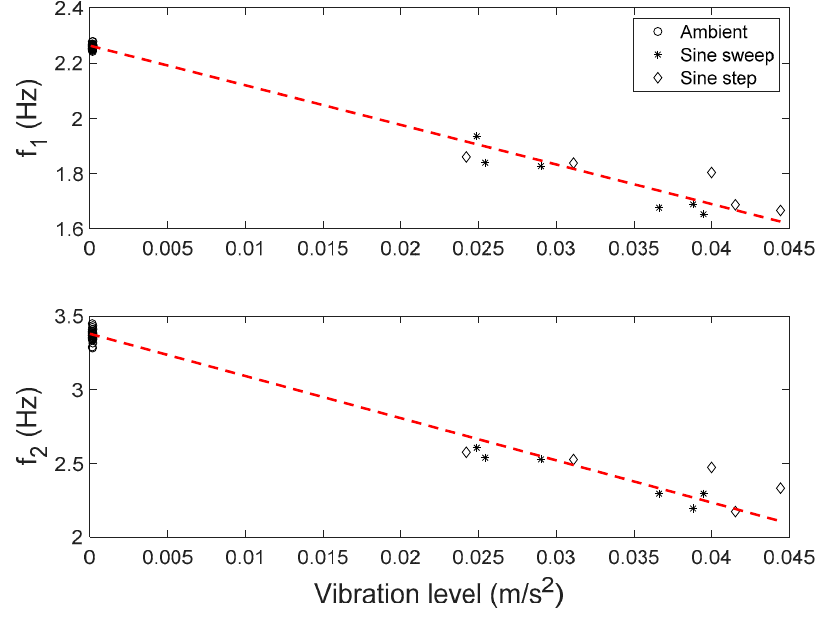
Figure 14. Identified natural frequencies vs. vibration levels.